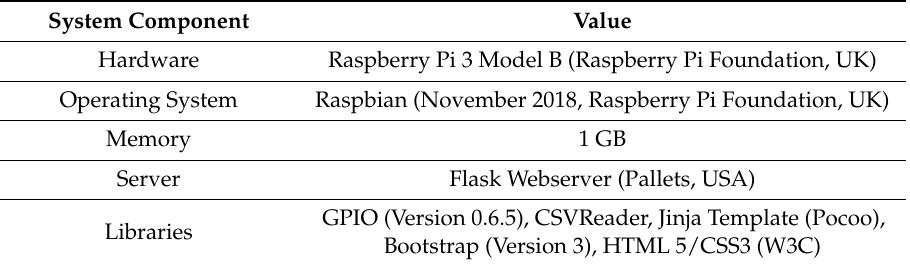
Table 6. Simulation and testing